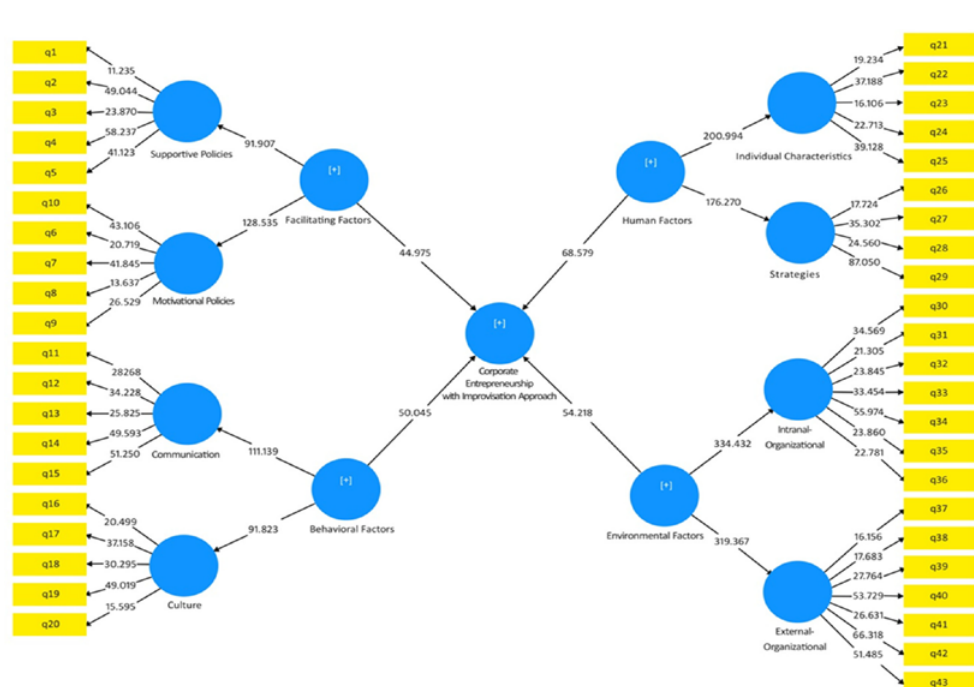
Fig. 2: t- statistics